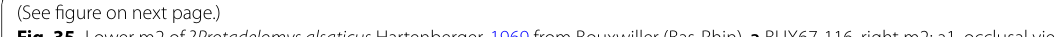
Fig. 35 Lower m2 of ? Protadelomys alsaticus Hartenberger, 1969 from Bouxwiller (Bas‑Rhin). a BUX67‑116, right m2; a1, occlusal view; a2, buccal aspect; a3, lingual aspect. b BUX67‑132, left m2; b1, occlusal view; b2, buccal aspect; b3, lingual aspect. c : BUX67‑130, right m2; c1, occlusal view; c2, buccal aspect; c3, lingual aspect. d BUX67‑127, left m2; d1, occlusal view; d2, buccal aspect; d3, lingual aspect. e CSBX49, right m2; e1, occlusal